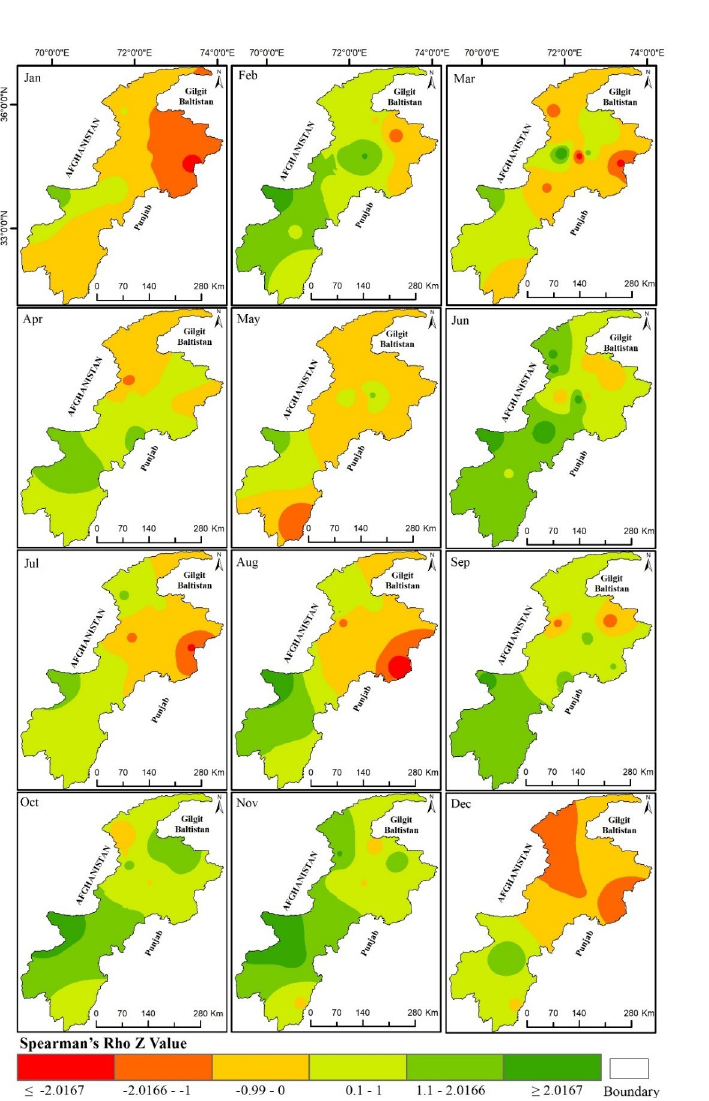
Fig 5. Spatial distribution Spearman’s Rho Z value for SPEI 1-month. (The Z value of ± 2.0167 is a significant trend at a 95% confidence